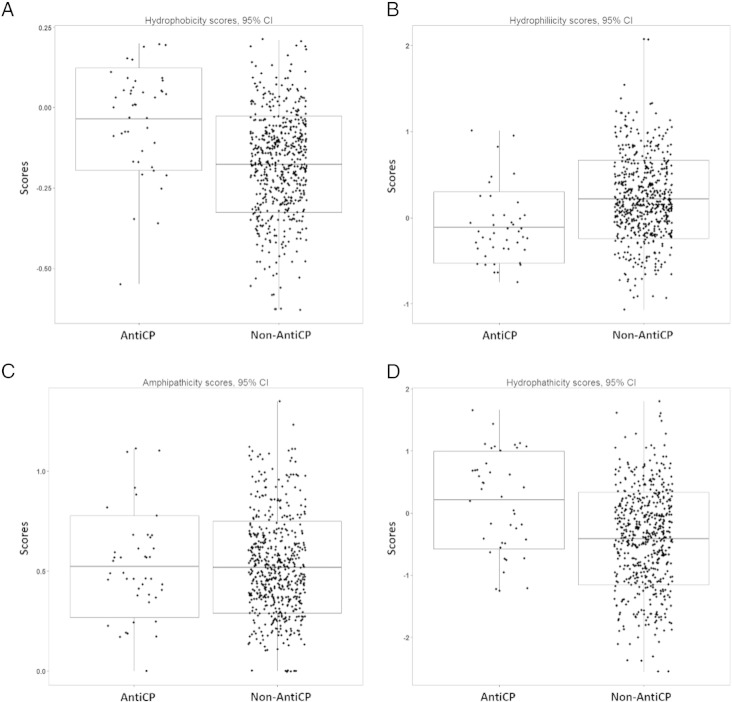
Physicochemical properties of the putative anticancer peptides compared with the non-anticancer peptides from fractions F2 and F5 of A. fulica mucus. Hydrophobicity (A), hydrophilicity (B), amphiphaticity (C) and hydrophathicity (D) scores of these peptides were computed by AntiCP. The boxplots were drawn by R program. The scores were shown in the black dots. The uppermost and lowermost ends represented maximum and minimum scores. The middle line indicated means and the two paralleled lines showed standard deviations.